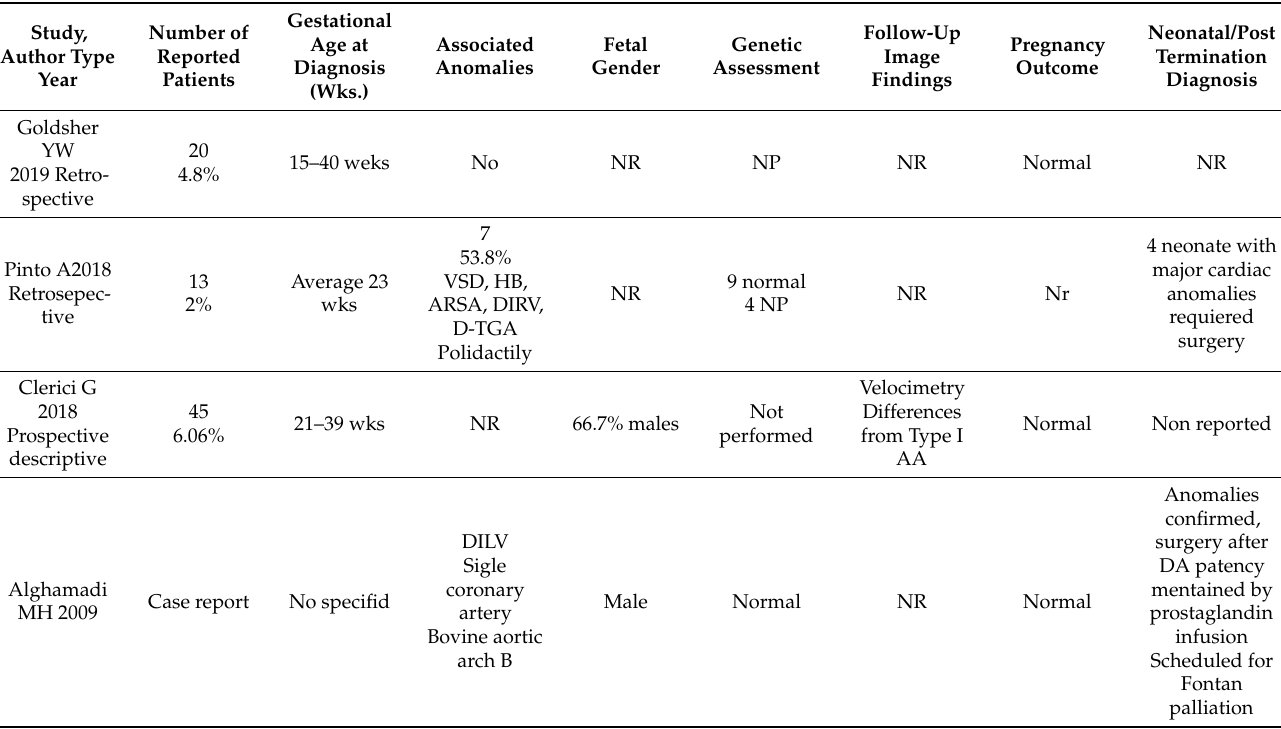
Table 2. Results of